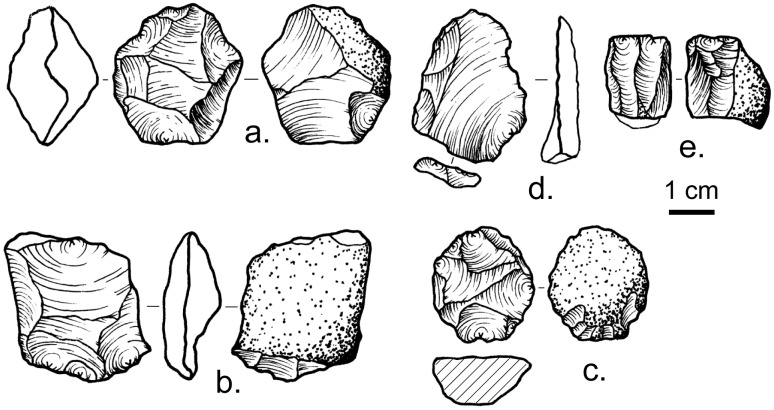
Lithic artifacts from Kisese II.a., discoidal core from spit XVIII, b.-c., recurrent Levallois cores from spits XIX and XX, respectively, d., retouched flake, possible Kombewa flake from split-pebble core from spit XVI, e., single platform bladelet core from spit XV. All artifacts are quartz, except c., which is chert. Illustrations are 1:1 scale.